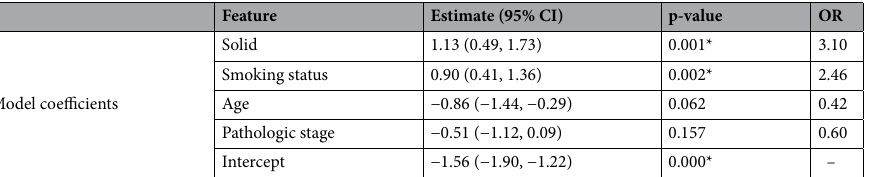
Table 3. Coefficients and odds ratios for individual features of the LungCNN-TMB model. Two-sided P-values were estimated using bootstrapping. A logistic regression model combines features from the 9 image features of LungCNN-Histo and 4 clinical features (age in years, sex, pathologic stage, smoking status) to predict TMB status. The image features (quantified as proportion of total tumor area) and age (in years) are treated as continuous variables, pathologic stage (I–IV) as ordinal, and smoking status (binary) and sex (M,F) as categorical. Features in this table represent those providing best model via cross-validation (see “Methods”). OR odds